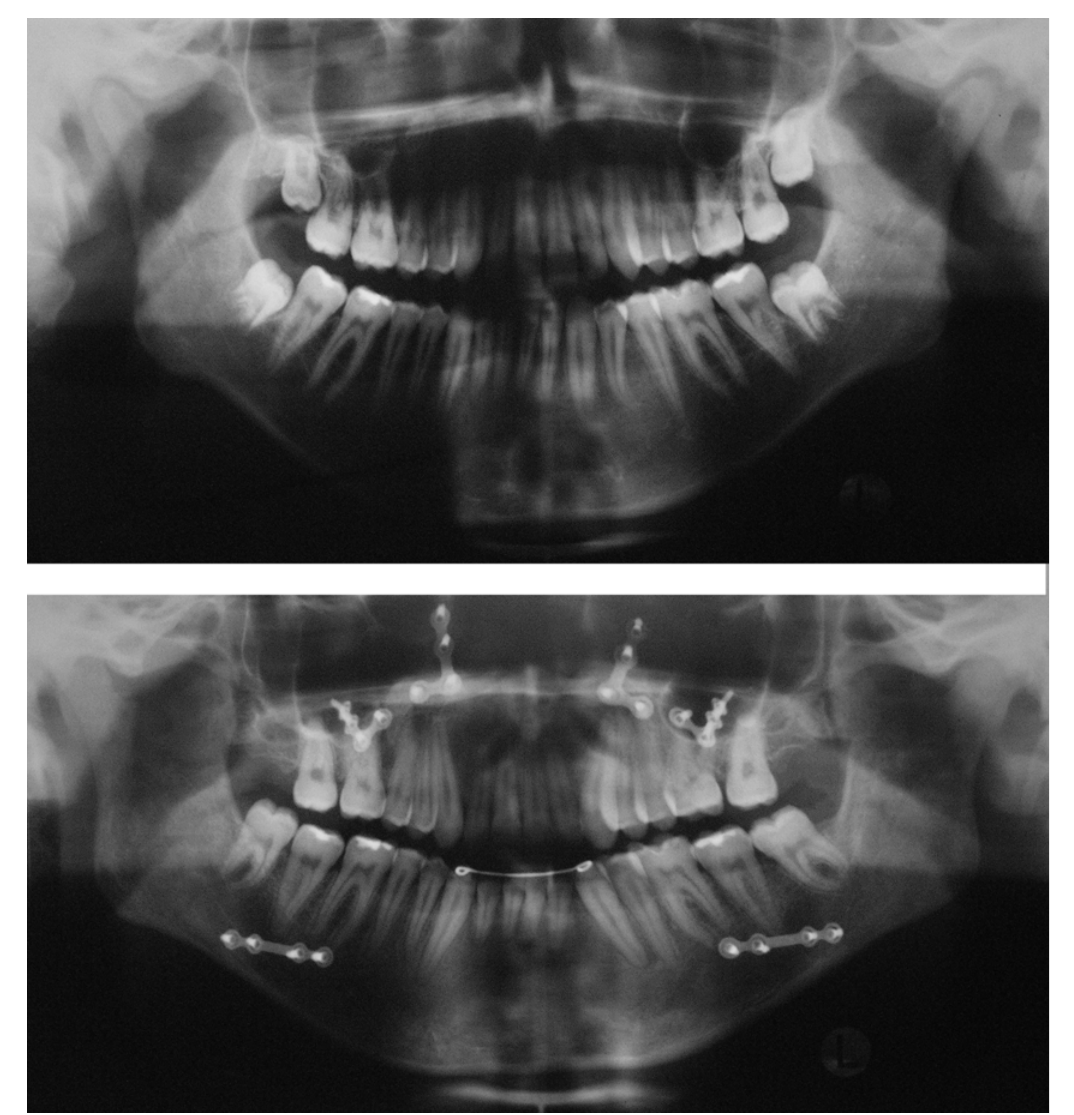
FIGURE 8- A- Pretreatment panoramic radiographs. B- Posttreatment panoramic